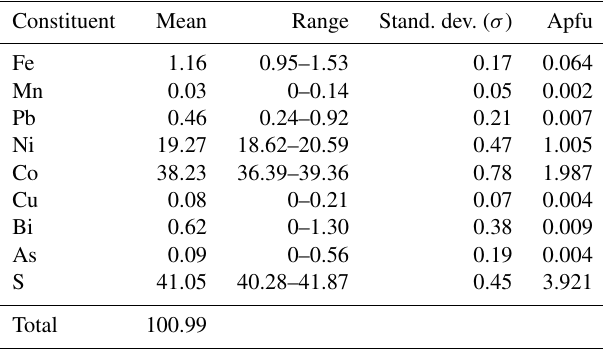
Table 2. Chemical data (wt%) for grimmite grain used for single-crystal X-ray study ( n = 13).